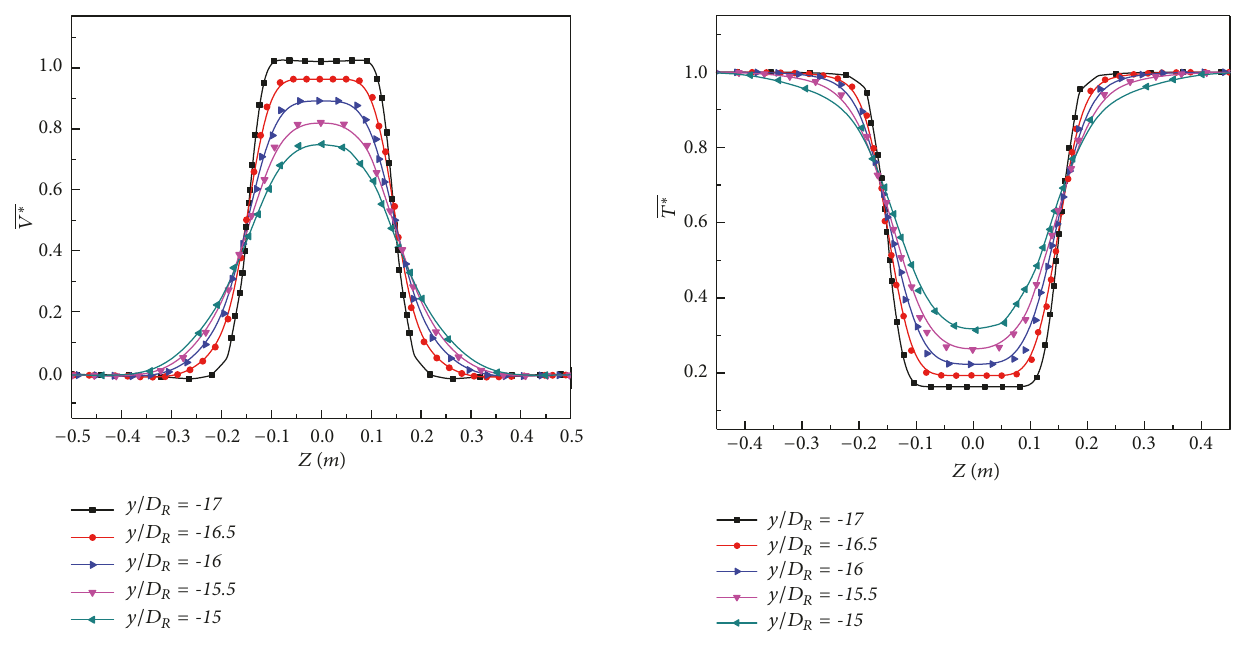
Figure 17: Dimensionless time-averaged temperature of different points in center plane.